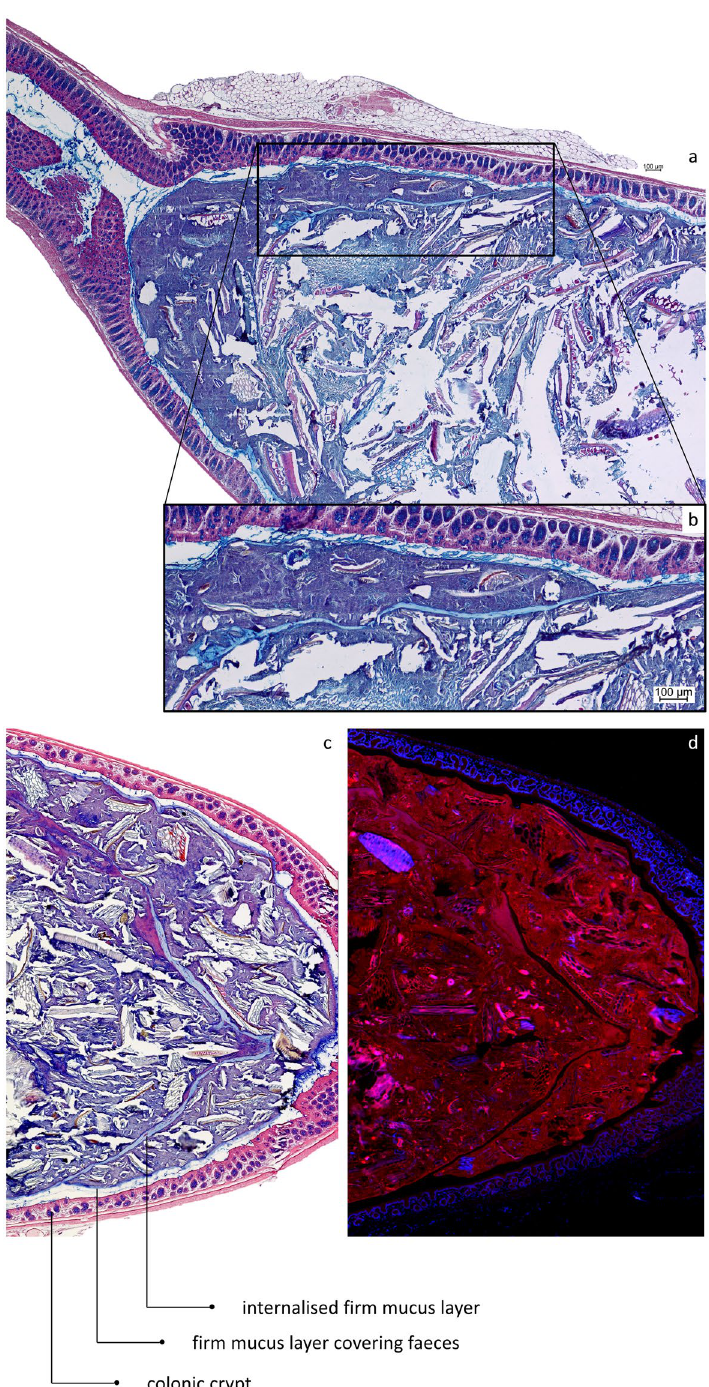
Figure 5. After collisions between faecal pellets in the distal colon, the mucus layers covering their surface can be internalised into the resulting composite pellet. ( a ) AB/H/E stained longitudinal section of distal mouse colon. ( b ) Close-up showing the internalised firm mucus layer. ( c ) AB/H/E stained longitudinal section of distal mouse colon. A firm mucus layer devoid of bacteria is found inside the pellet. ( d ) FISH stained (Bacteria in red; nuclei in blue) longitudinal section of mouse distal colon, the internalised firm mucus layer is recognised by the absence of